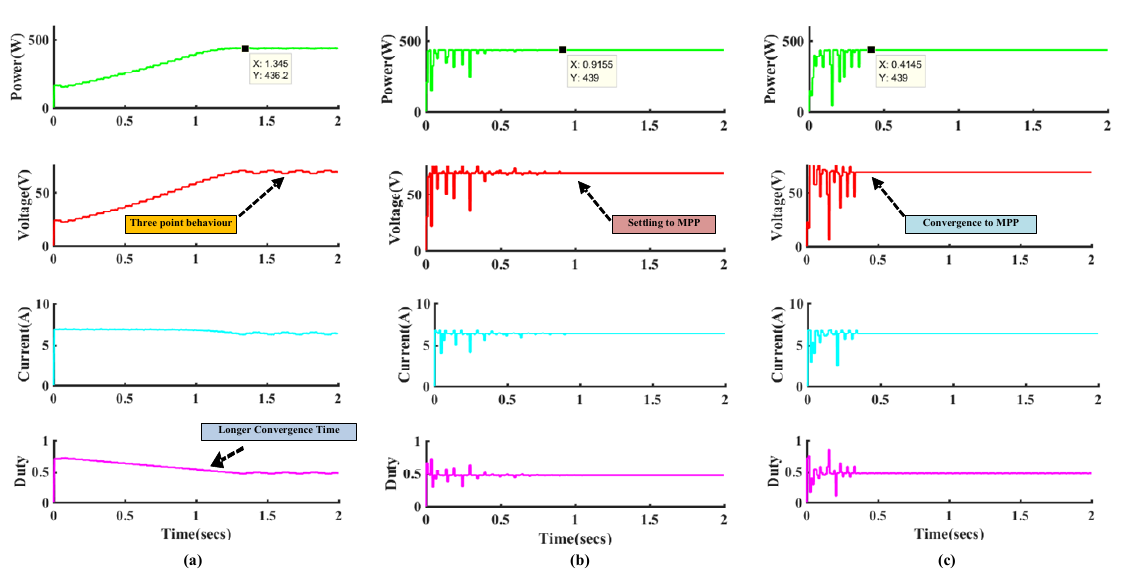
Figure 10. Simulated waveforms of ( a ) P&O, ( b ) PSO, and ( c ) SHO methods under Uniform irradiation (Pattern 1).